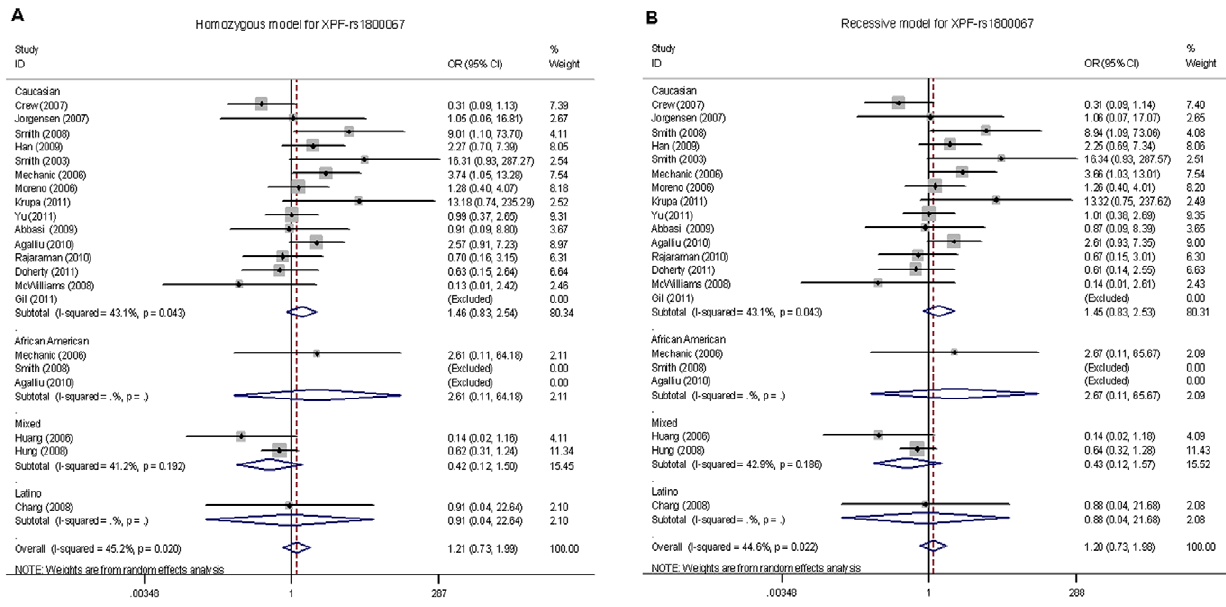
Figure 3. Forest plot of cancer risk associated with the XPF -rs1800067 polymorphism stratified by ethnicity. (A) AA vs. GG in a homozygous model and (B) AA vs. (AG + GG) in a recessive model by the random-effects for each of the 23 published studies. For each study, the estimates of OR and its 95% CI were plotted with a box and a horizontal line. The symbol filled diamond indicates pooled OR and its 95% CI. No significant association between the XPF -rs1800067 polymorphism and cancer risk was found.